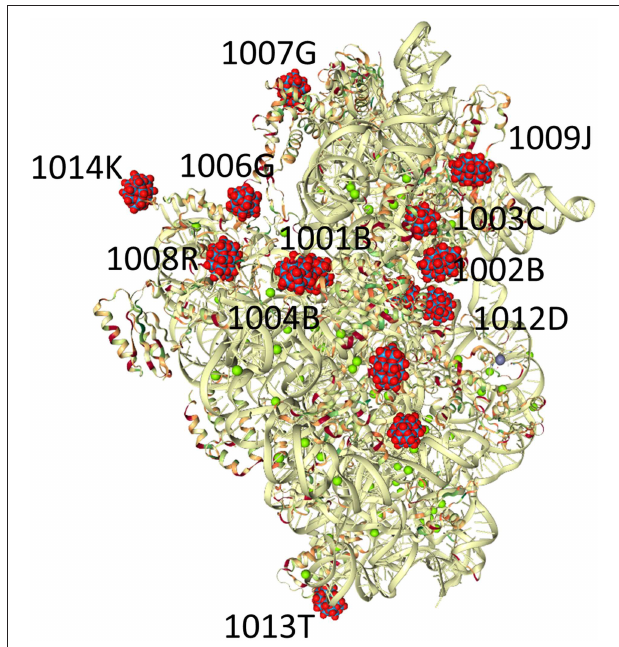
FIGURE 3 | Crystals of the small ribosomal subunits (T30S) were soaked for a few minutes in solutions containing small amounts of the Wells-Dawson tungstate complex (P 2 W 18 , PW 18 by the authors, WO2 in the PDB). The structure of the complex of the ribosomal subunits with the cluster (PDB Ref code 1 I 94) is shown. The P 2 W 18 residues that are described in detail in this manuscript are P 2 W 18 numbers 1,014 and 1,006 for the discrete clusters and 1,001 and 1,004 for the Double Wells-Dawson cluster ( Pioletti et al.,